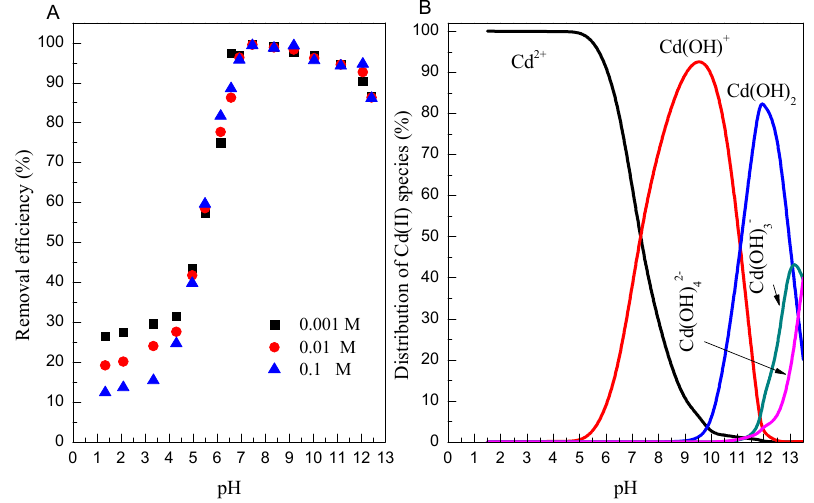
Figure 3. ( A ) Effect of pH on Cd(II) adsorption onto Mn oxide ( C = 10 mg/L, m / v =1 g/L, T = 298 K); ( B ) The distribution of Cd(II) species in aqueous solutions ( I = 0.01 mol/L NaClO 4 , T = 298 K).